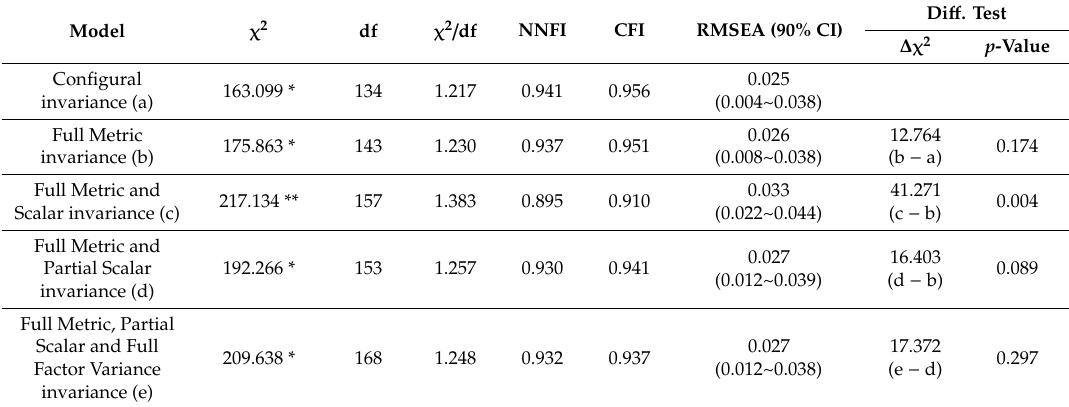
Table 9. Fit indices for invariance